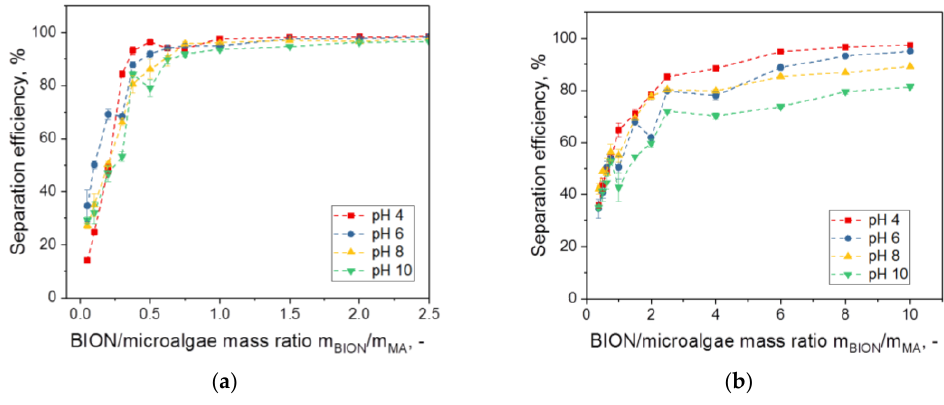
Figure 4. Separation efficiency of S. ovalternus ( a ) and C. vulgaris ( b ) at different pHs in the relevant nanoparticle dosage range for each.